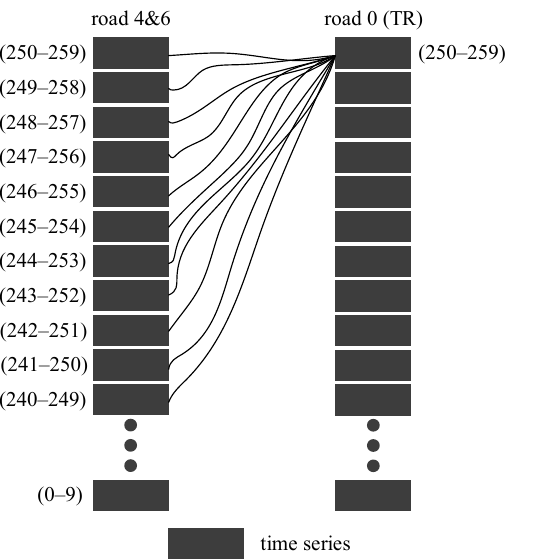
Table 4. Flow ratio (%) of roads 1 and 2 to road 6.